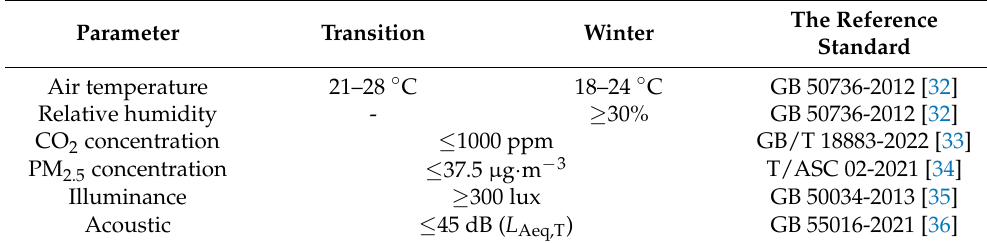
Table 4. Calculation basis of compliance rate of the indoor environment.